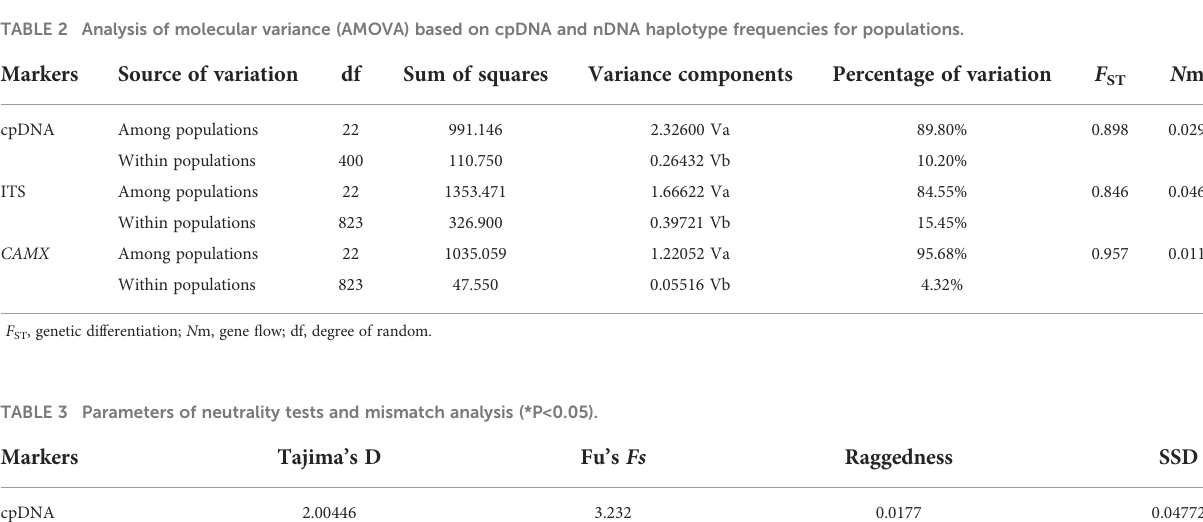
SSD, The variance of an observation of a point of difference with an expected value.